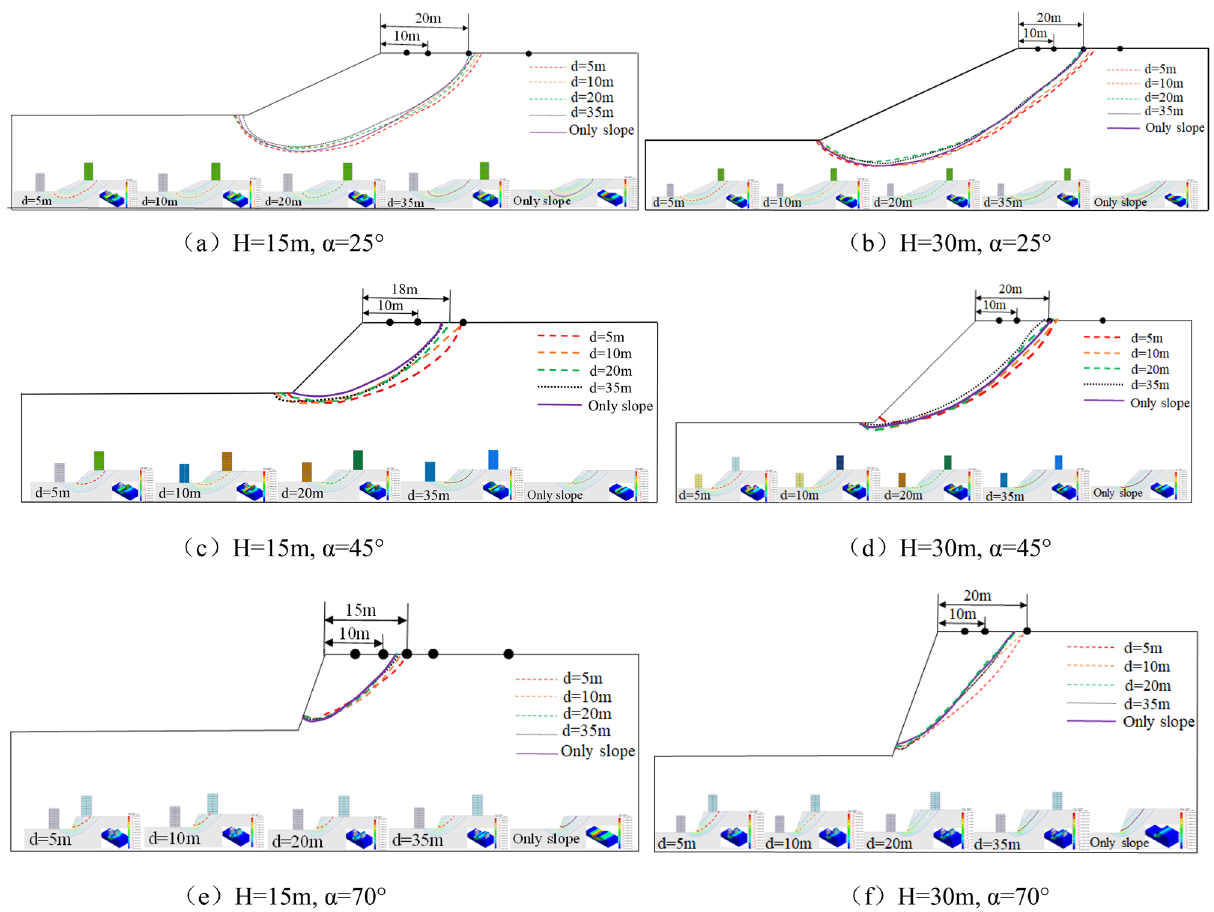
Figure 14. Summary drawing of the most dangerous sliding surface of each model.